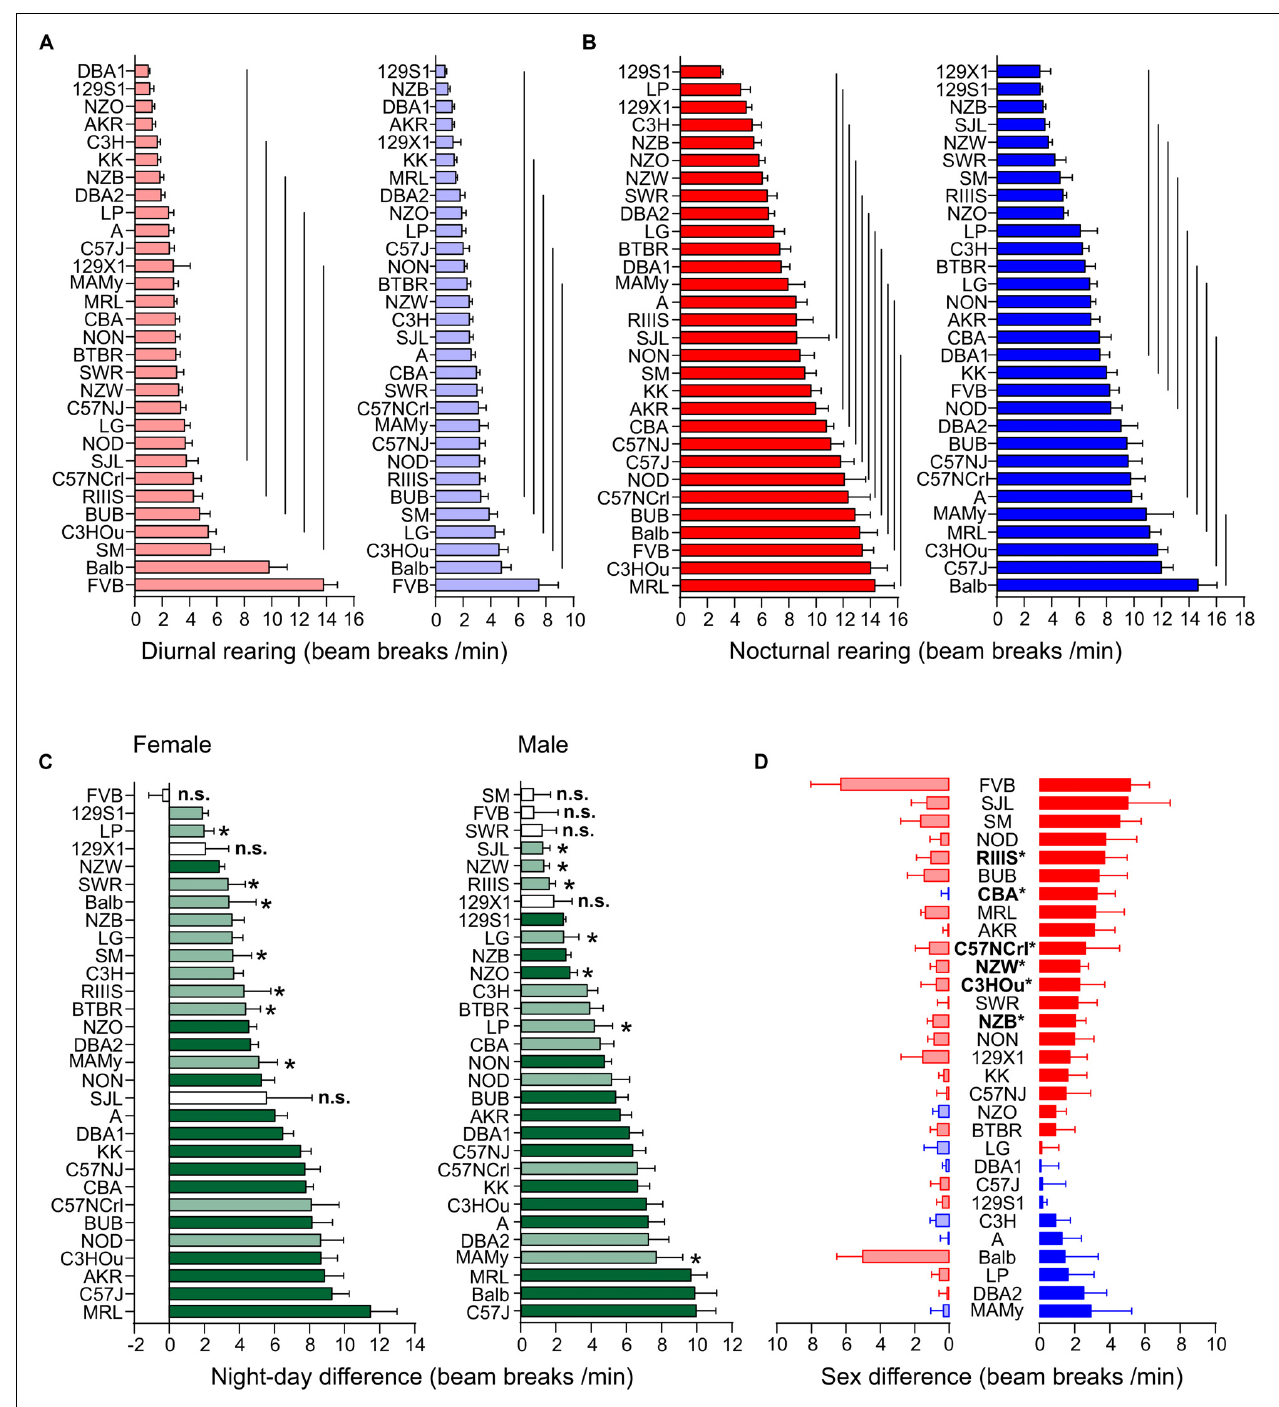
FIGURE 5 | Strain, day–night and sex differences in rearing. (A,B) Strain-dependence of diurnal (A) and nocturnal (B) rearing activity. The values are given as mean values averaged from females (left, red) and males (right, blue), both sexes with standard errors of the mean and the vertical lines connect groups with homogenous means according to Tukey’s post hoc test. (C) Day–night differences were ranked and Cohen’s D calculated. Significant differences at p < 0.05 are indicated with asterisk and p -levels < 0.001 were not marked; “n.s.” not significant. The effect sizes ranged from D = 0.66 (Balb females) to D = 5.35 (CBA females) and are indicated in light green ( D = 0.66 and D < 2) and dark green ( D ≥ 2). (D) Sex differences were apparent in six strains at p < 0.05. The strains are ranked from largest to smallest sex difference for the scotophase, beginning, at the top, with strains, where females (red) were more active than males, while blue columns illustrate strains with more active males. To the left, nocturnal values are associated with the respective diurnal values and are displayed in light colors. All values are displayed as means ± standard error of the difference. Asterisks and bold font indicate significant sex differences, * p < 0.05.